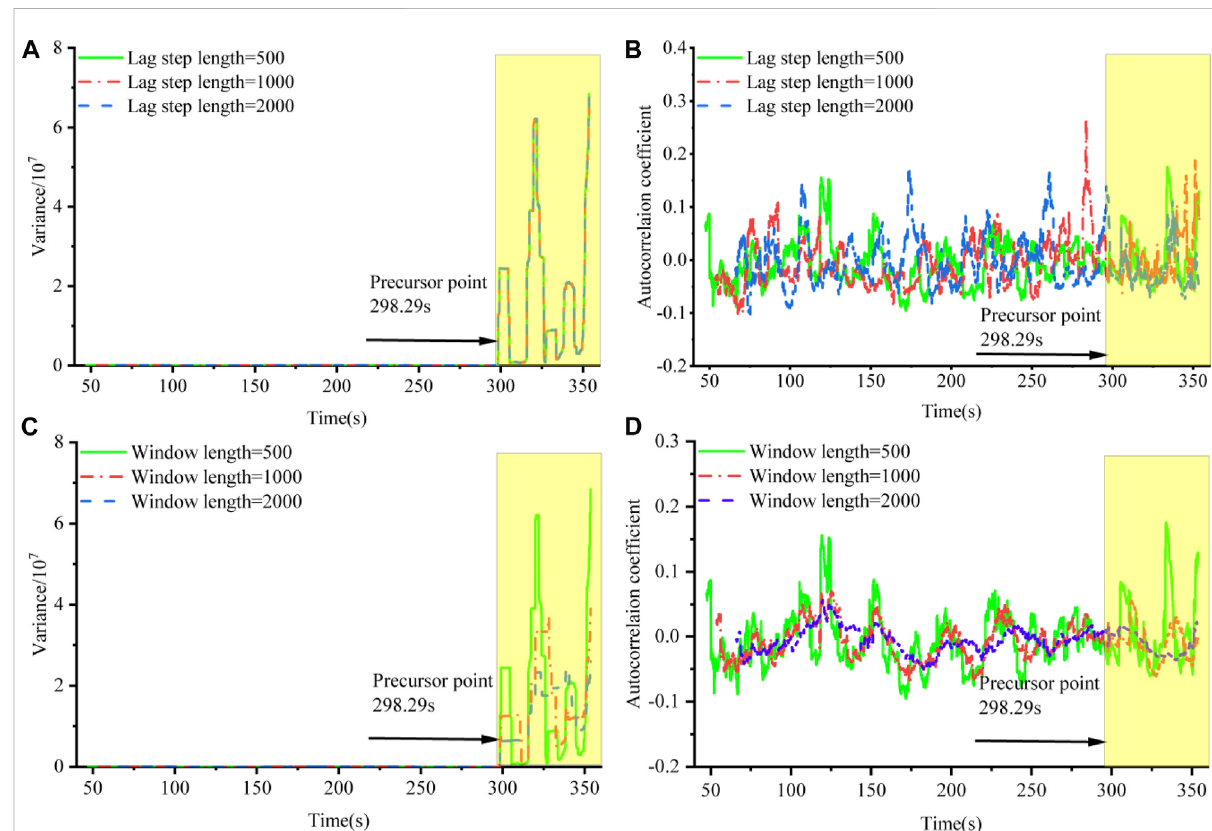
FIGURE 5 Effect of lag step and window length on the CSD indicators of the autoregression model. (A) effect of lag step length on variance for a fi xed windowlength, (B) effectoflagsteplengthontheautocorrelationcoef fi cientfora fi xedwindowlength, (C) effectofwindowlengthonvariancefora fi xed lag step length, and (D) effect of window length on the autocorrelation coef fi cient for a fi xed lag step